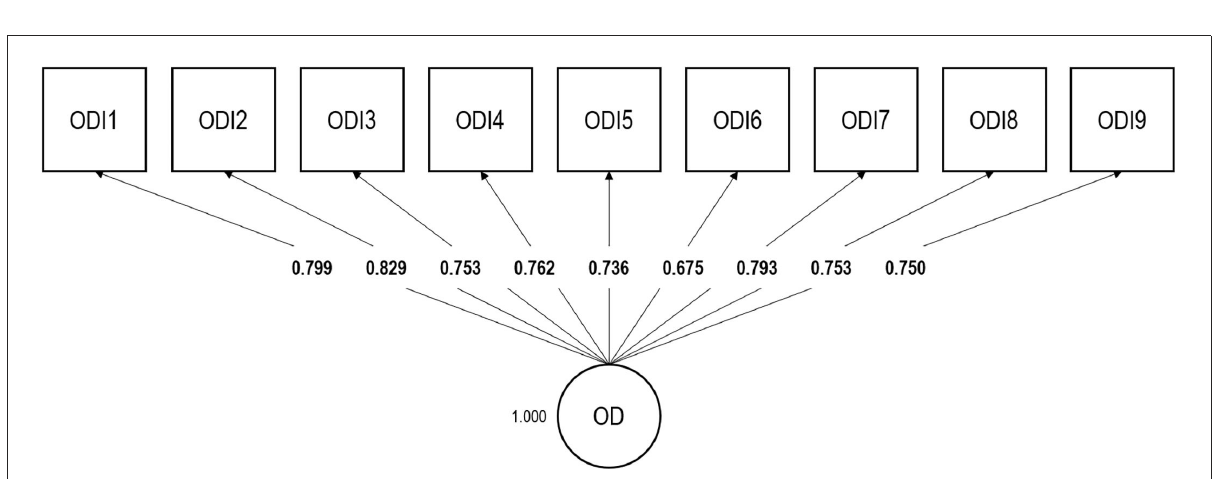
FIGURE2 Confirmatory factor analysis of the Occupational Depression Inventory—factor loadings. OD, Occupational Depression factor. N = 963 (no missing values); ODI1, anhedonia; ODI2, depressed mood; ODI3, sleep alterations; ODI4, fatigue/loss of energy; ODI5, appetite alterations; ODI6, feelings of worthlessness; ODI7, cognitive impairment; ODI8, psychomotor alterations; ODI9, suicidal ideation.